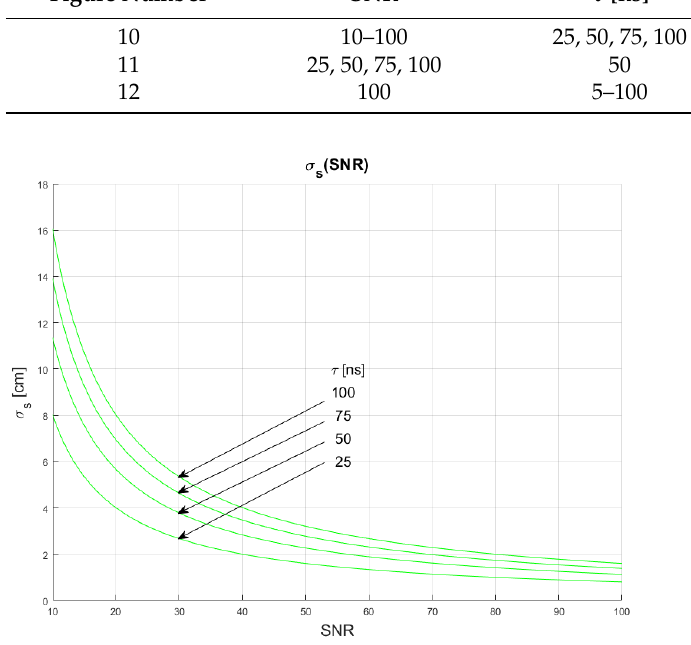
Figure 10. Plots of the dependance of the measurement’s uncertainty calculated using Equation (16) for signal parameters shown in Table 4. Comparable results are shown in Figure 4.